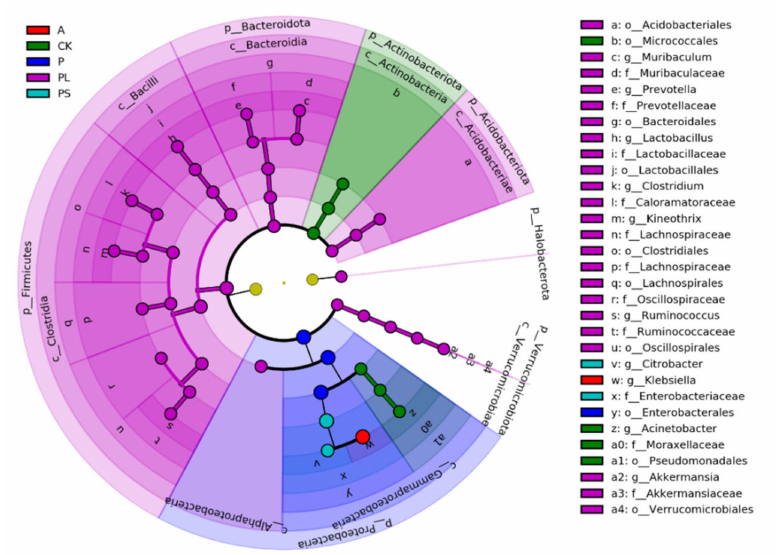
Figure 7. Cladogram of bacterial biomarkers, from the phylum (innermost ring) to genus (outermost ring) level, with an LDA score >4. Differential bacterial taxa are marked by lowercase letters. Each small circle at different taxonomic levels represents a taxon at that level, and the diameter of the circle is proportional to the relative abundance. The coloring principle is to color the species with no significant difference as yellow, and the other different species as the group with the highest abundance of the species. Different colors represent different groups, and nodes with different colors represent the communities that play an important role in the group represented by the